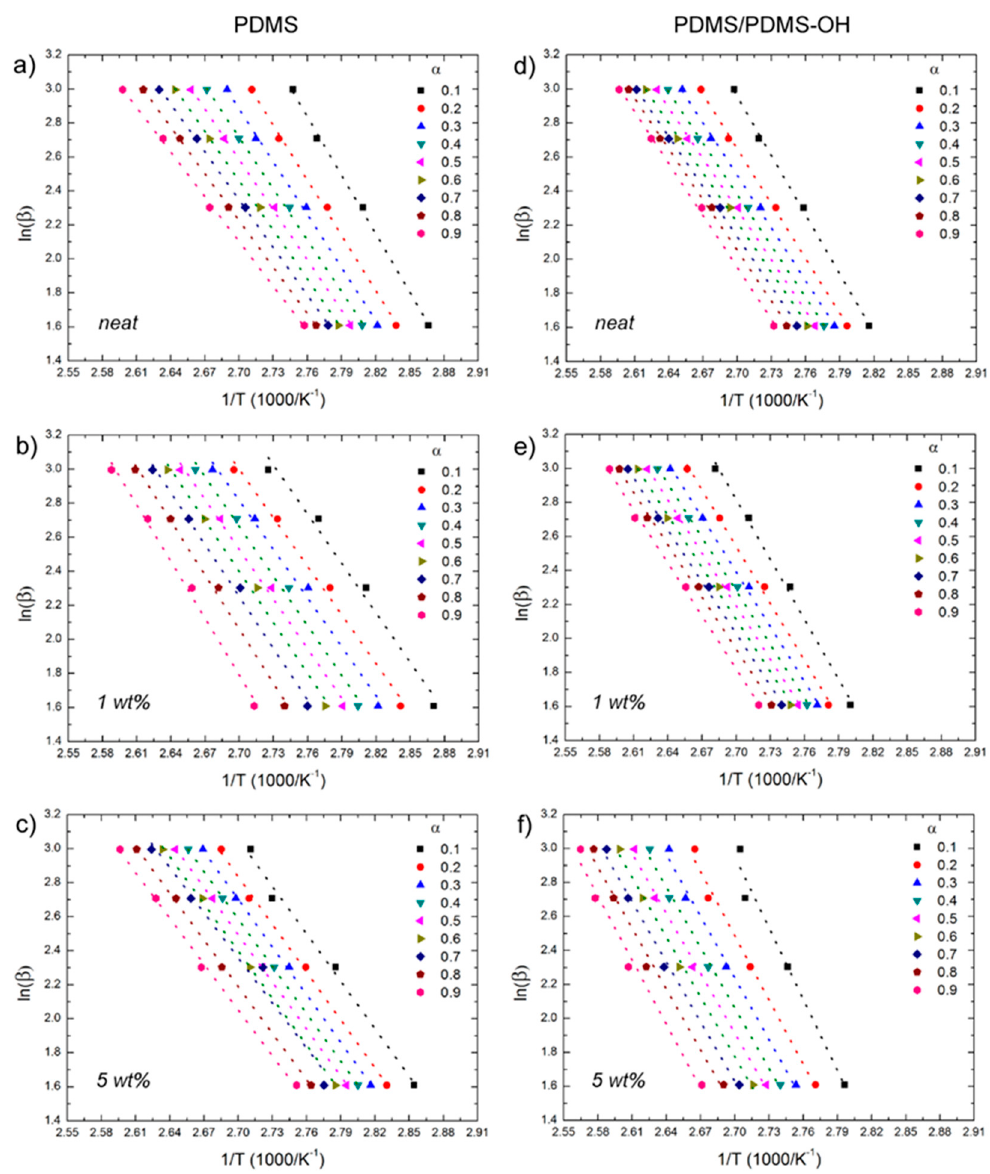
Figure 6. Plots of ln( β ) versus 1 / T at di ff erent extents of conversion according to the Ozawa–Flynn–Wall model for nanocomposites with the PDMS and PDMS / PDMS–OH (75:25 w / w) matrix: ( a , d ) unfilled; ( b , e ) filled with 1 wt% GNP–DNA; ( c , f ) filled with 5 wt% GNP–DNA.